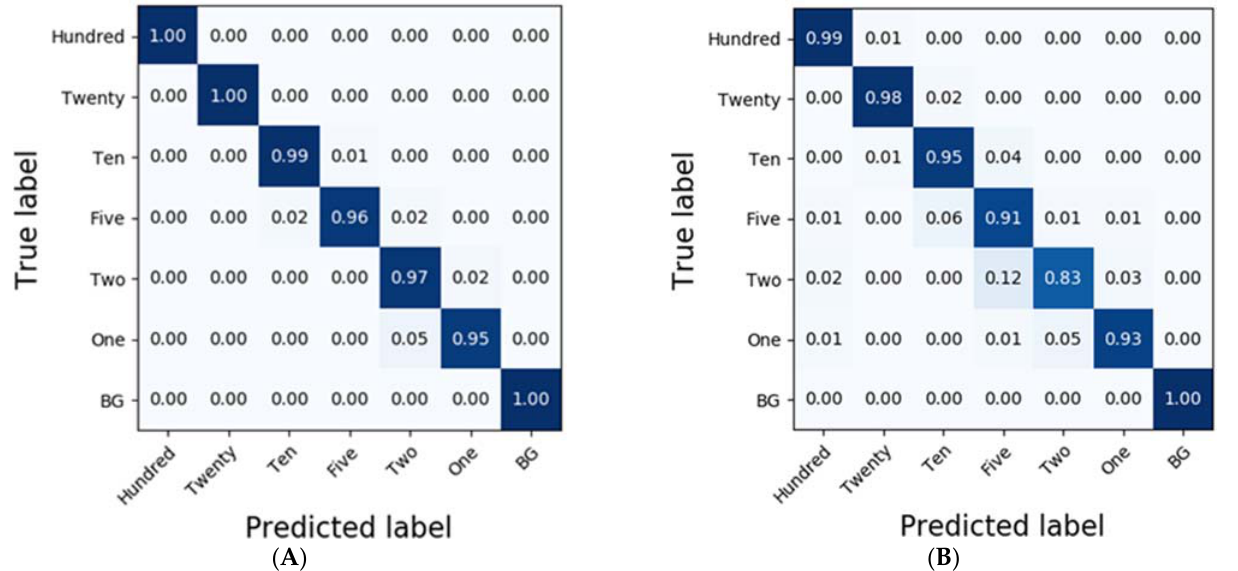
Figure 7. Confusion matrix of the classification result for spinach dilutions of the residues using CNN-1D. The calibration result ( Ac = 0.98) is ( A ) and the validation result ( Av = 0.94) is ( B ).